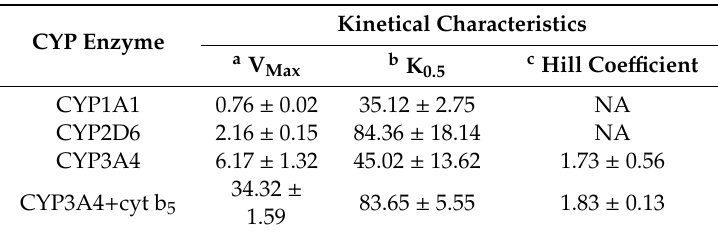
Table 5. The characteristics of the kinetics of the oxidation of vandetanib to N -desmethylvandetanib by human CYP1A1, 2D6 and